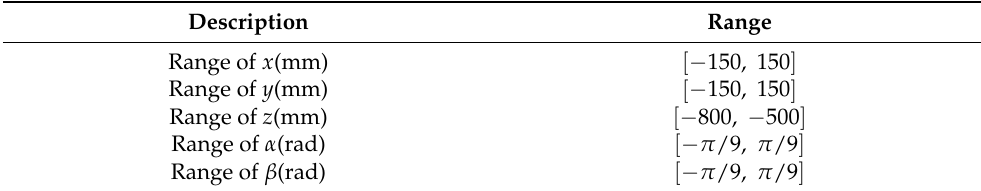
Table 2. Motion range of the end-effector in training data